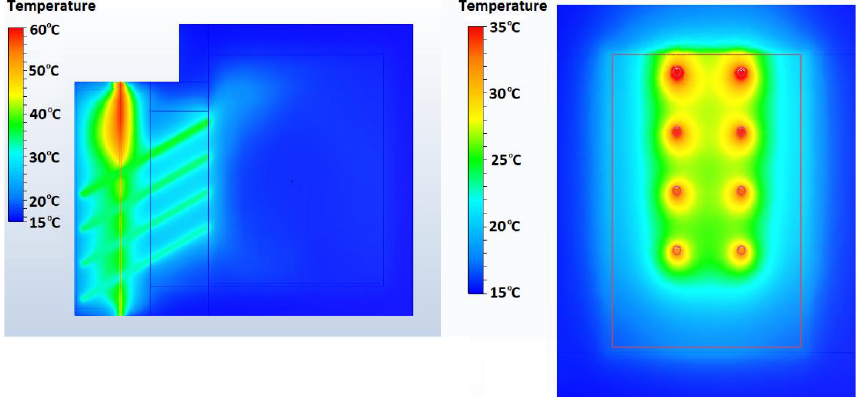
Figure 11. Numerical simulation for CW02 — 100 W/m 2 .